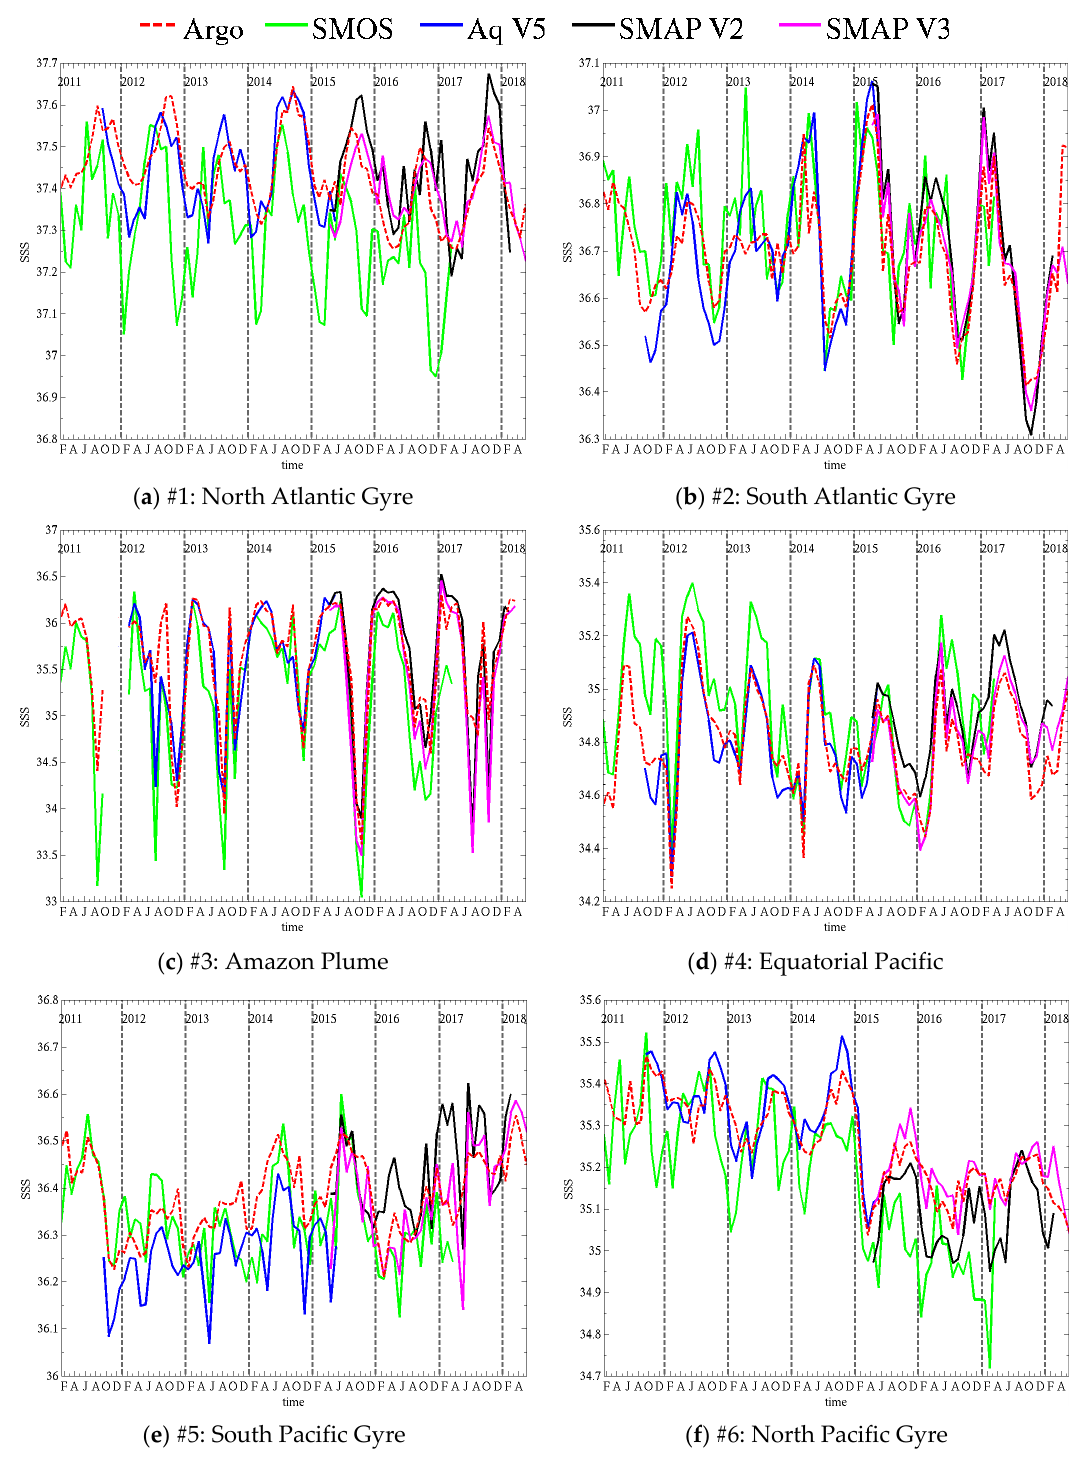
Figure 12. Time series of SSS from (red) Argo, (green) SMOS, (blue) Aquarius and (black) SMAP for regions of interest 1–6 reported in Figure 2.